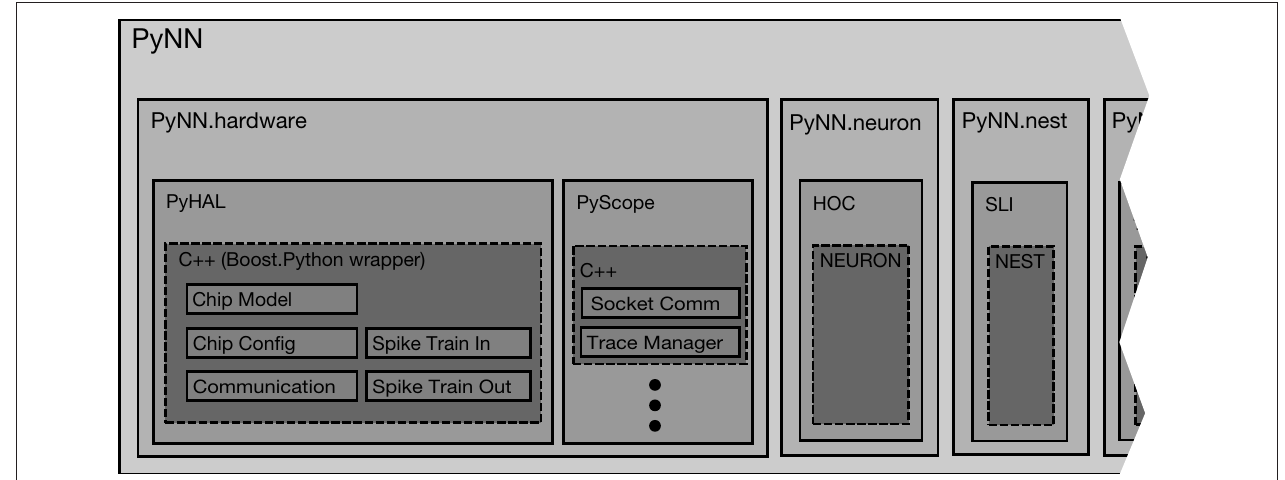
FIGURE 2 | Schematic of the software framework for the operation of the hardware system. It is integrated into the Python-based, simulator-independent language PyNN, which also supports back-ends like NEURON, NEST and more.